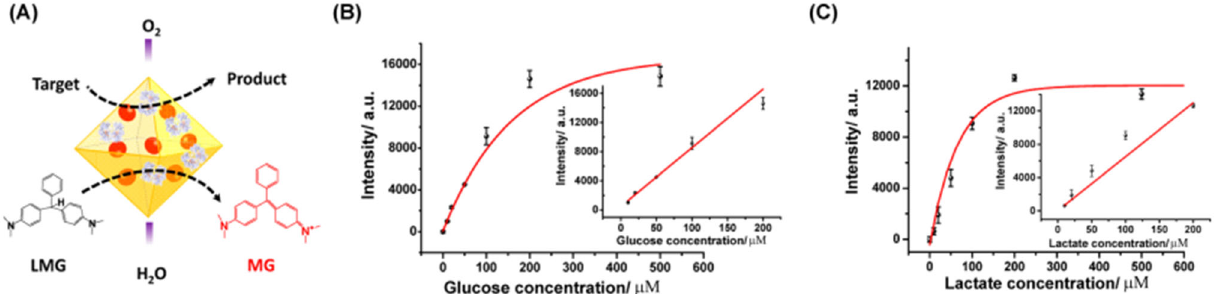
Figure 4. ( A ) Schematic illustration of in vitro detection of glucose (or lactate). ( B ) Plots of Raman intensity of malachite green at 1615 cm − 1 vs. glucose concentrations. Inset: linear response to glucose concentrations. ( C ) Plots of Raman intensity of malachite green at 1615 cm − 1 vs. lactate concentrations. Inset: linear response to lactate concentrations. Reprinted with permission from [30]. Copyright © 2017 American Chemical Society.